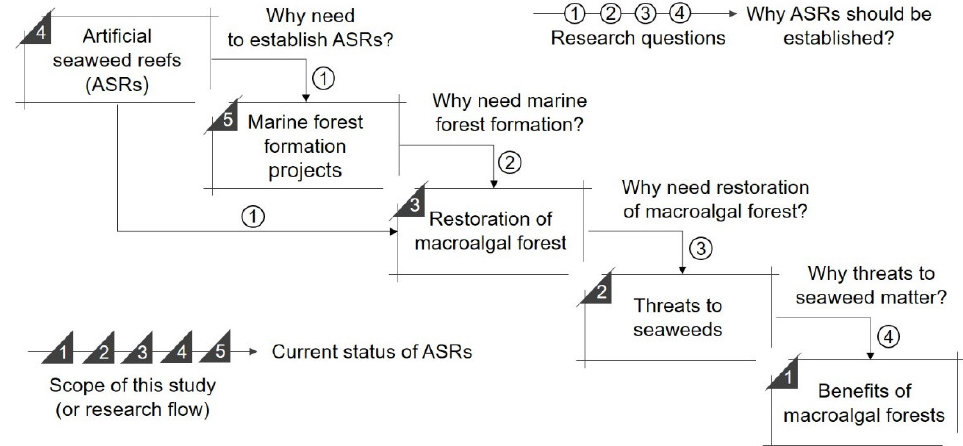
Figure 1. Research questions and scope of this study.